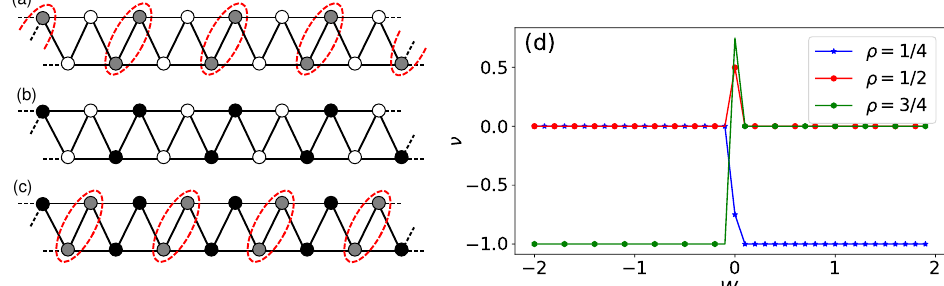
Figure 3: Structures of the three insulating phases of Fig. 2 : (a) the dimer insulator at ρ = 1 / 4; (b) the CDW at half-filling; and, (c) the dimer insulator at density 3 / 4. The white (black) circles denote empty (filled) sites with density 0.0 ( 1.0 ) , whereas the grey circles signify half-filled sites with density 0.5. The red dashed curves represent the formation of dimers. (d) The corresponding Berry phase as a function of W for = 1.0 and t = filling fractions 1 / 4, 1 / 2 and 3 / 4 with t 1 2